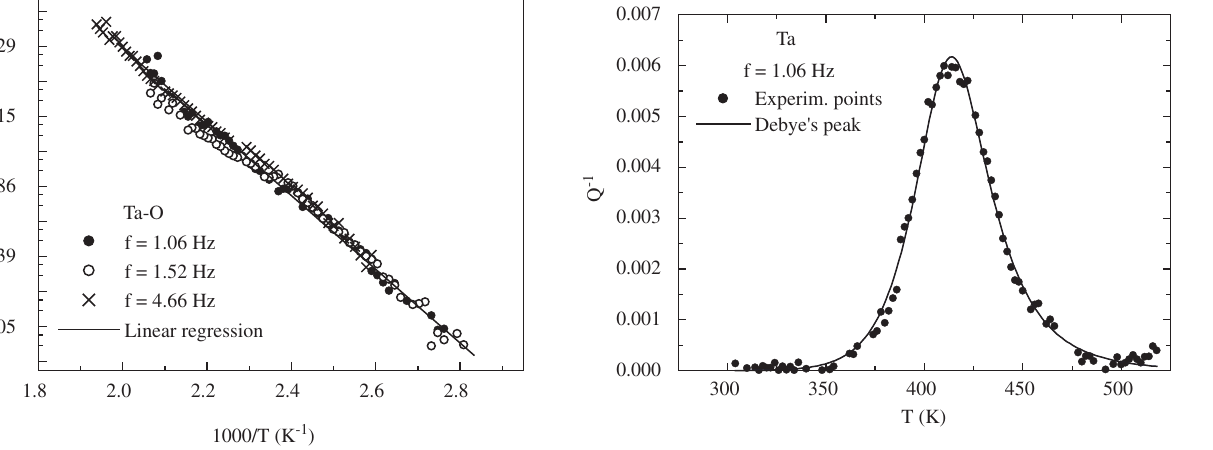
Figure 7. Diffusion coefficient as a function of the inverse of the tempera- ture for Ta-O relaxation process measured with frequencies of 1.06 Hz (•), 1.52 Hz (( ο ), and 4.66 Hz (×)., and 4.66 Hz (×).